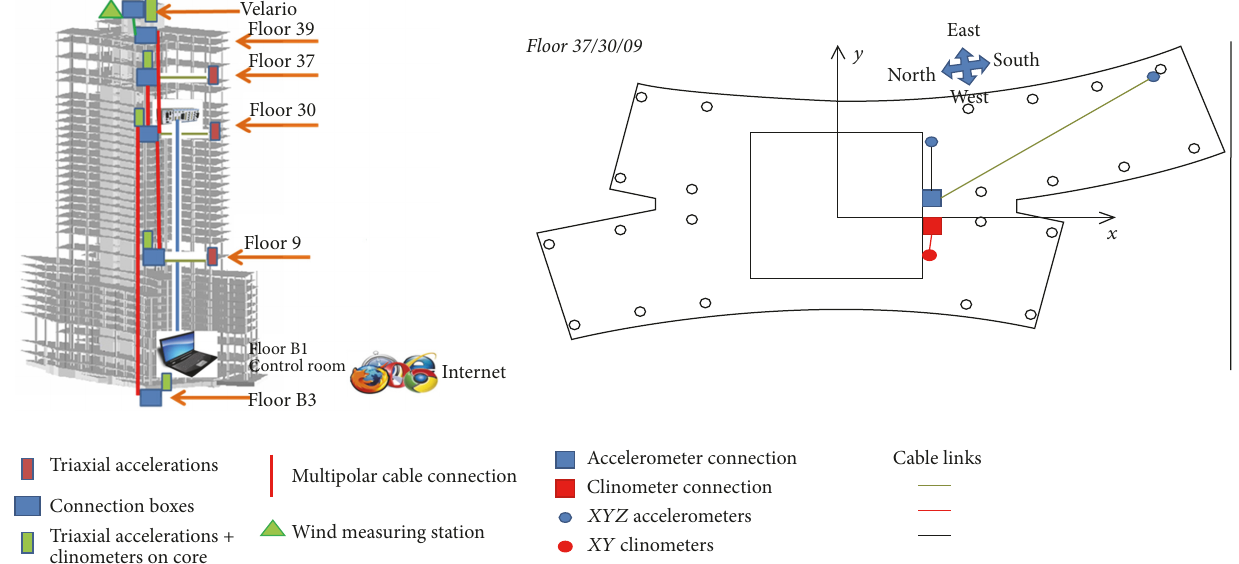
Figure 1: Layout of the monitoring system. Floor B3 and Velario differ from floors 37/30/09 because of the lack of the external accelerometers. In each accelerometer location, there are three accelerometers measuring in 𝑥 , 𝑦 , and 𝑧 (out of the figure) directions. In inclinometer location, there are two inclinometers measuring around the 𝑥 and 𝑦